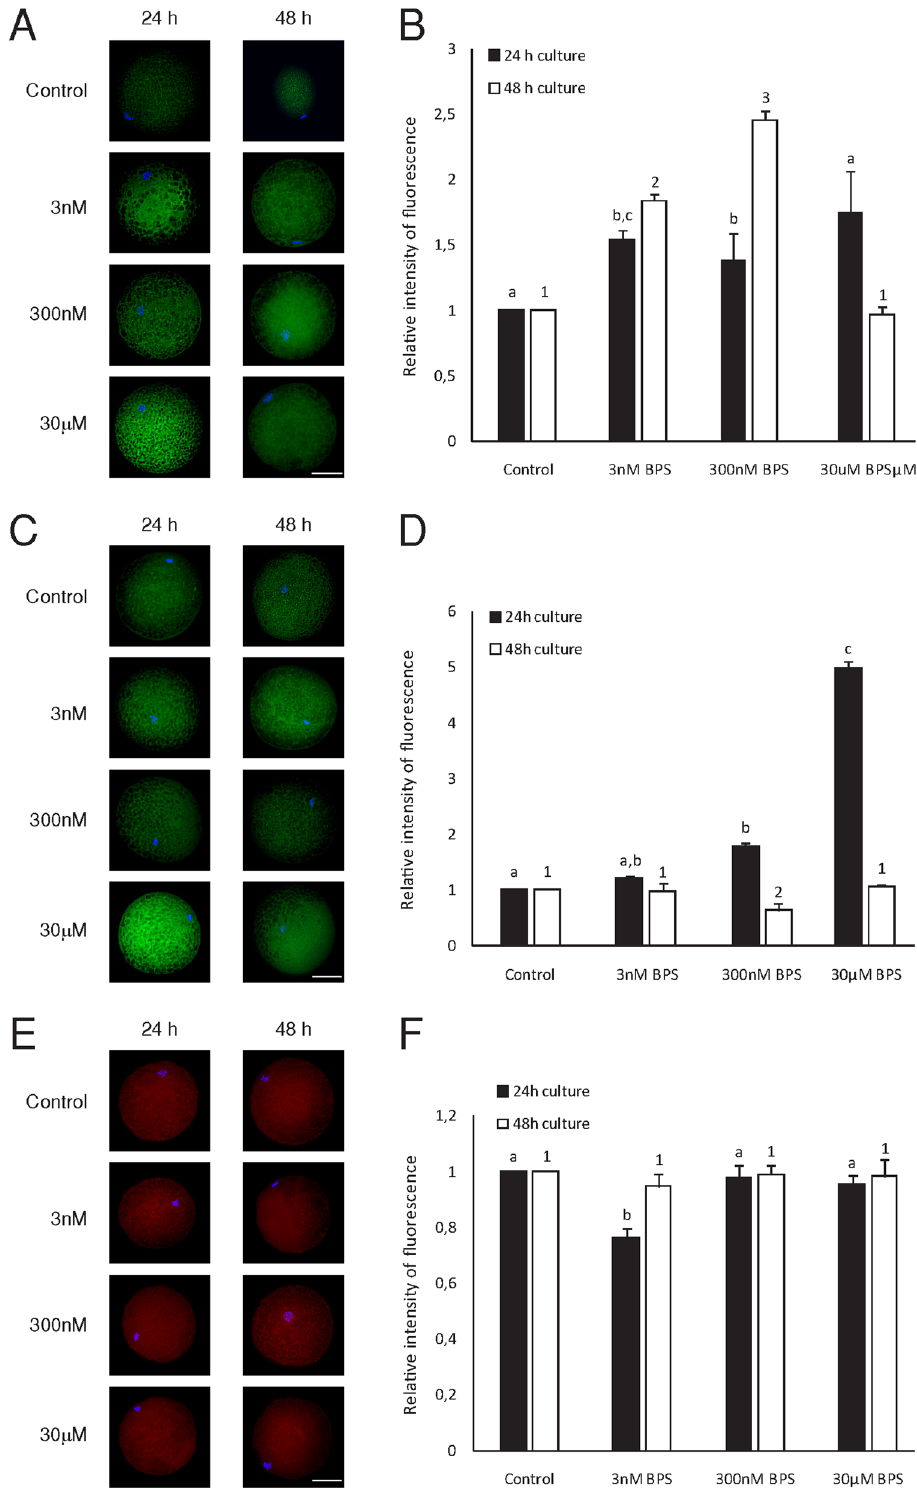
Figure 4. Effects of BPS on ER α , ER α , and aromatase during oocyte maturation. Representative pictures showing changes in the distribution of ER α ( A ), ER β ( C ), and aromatase ( E ) in oocytes cultured for 24 h and 48 h in vitro after BPS (3 nM, 300 nM, and 30 µ M) treatment. Green colour indicates ER α and ER β , red indicates aromatase, and blue indicates chromatin. Scale bar = 50 µ M. Graphs ( B ), ( D ), and ( F ) represent differences in the relative fluorescence intensities of ER α , ER β , and aromatase. The data are expressed as the mean ± SEM of three independent experiments in which at least 20 oocytes were analysed. Different superscript letters denote the statistical significance among experimental groups for 24 and 48 h of in vitro culture, respectively (P <